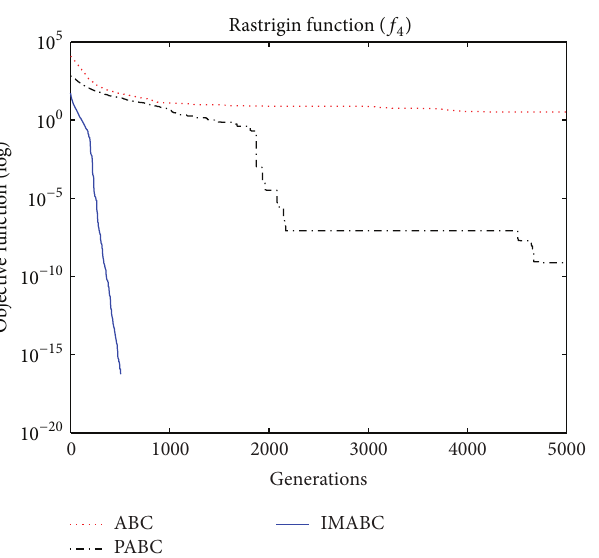
Figure 8: 𝑓 6 function convergence performance